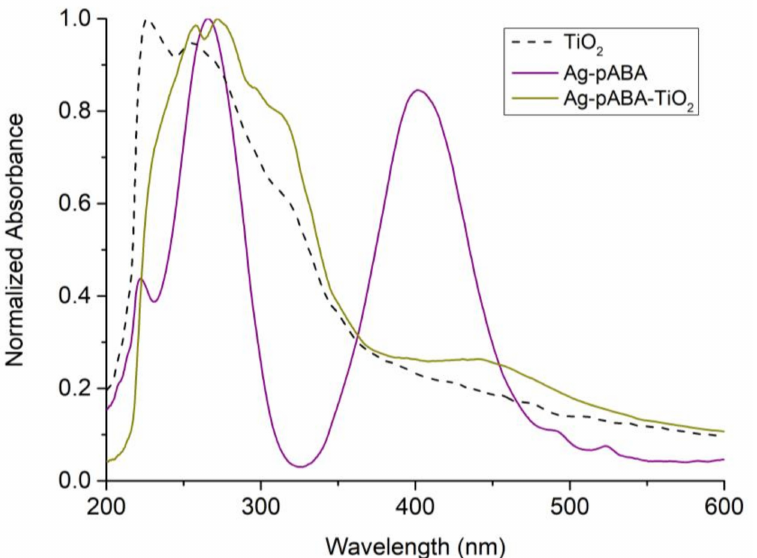
Figure 7. UV-Vis absorption spectrum of TiO 2 (black dashed trace), Ag-pABA (purple trace), and Ag-pABA-TiO 2 (dark yellow